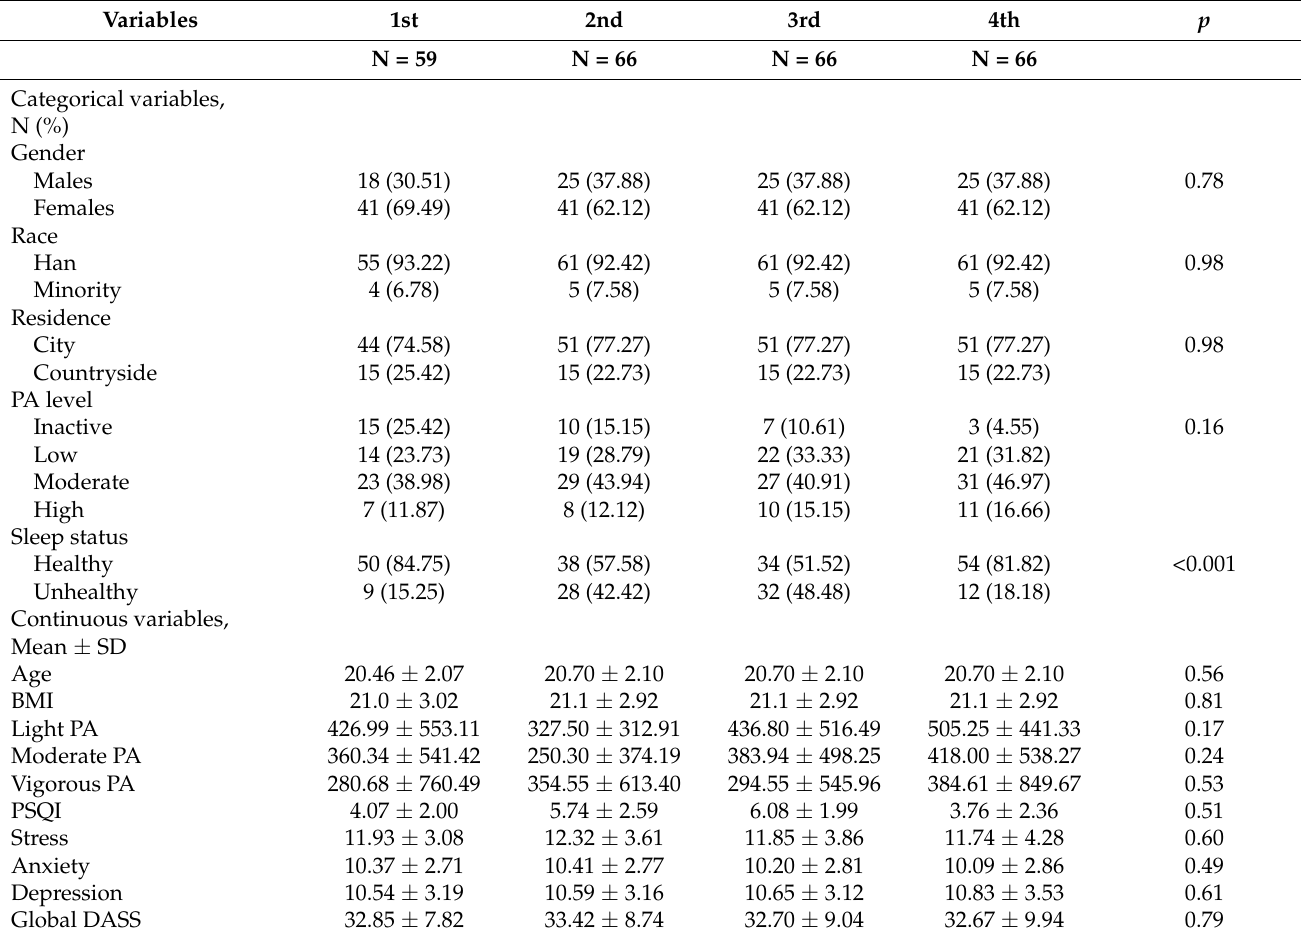
Table 1. Demographic information and descriptive